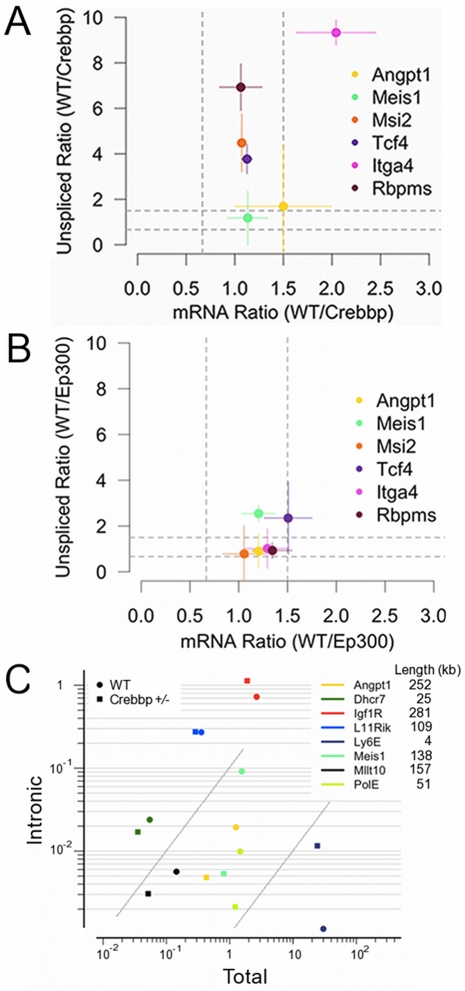
Changes in the ratio of unspliced message relative to total mRNA ratios in WT vs Crebbp+/− HSCs.(A) WT/Crebbp+/− ratios for total mRNA vs unspliced mRNA qRT signal for the indicated genes. Dashed grey lines mark the 1.5-fold limit used as a cut-off for differential expression. Points lying within the vertical grey lines but above the horizontal ones indicate little change in mRNA levels in WT vs Crebbp+/− cells but a reduction in the ratio of unspliced message. Plotted are median values with horizontal and vertical lines extending to indicate median absolute deviation for the mRNA and unspliced ratios, respectively. (B) WT/Ep300+/− ratios for total mRNA vs unspliced mRNA qRT signal for the indicated genes as in (A) showing little if any discrepant change in total and unspliced transcript levels. (C) Total mRNA vs Intronic qRT signal for the indicated genes in WT and Crebbp+/− HSCs. Grey lines indicate a slope of 1 on the log-log plot and are provided as a visual reference only. Gene lengths in kilobases (kb) are shown at the right.